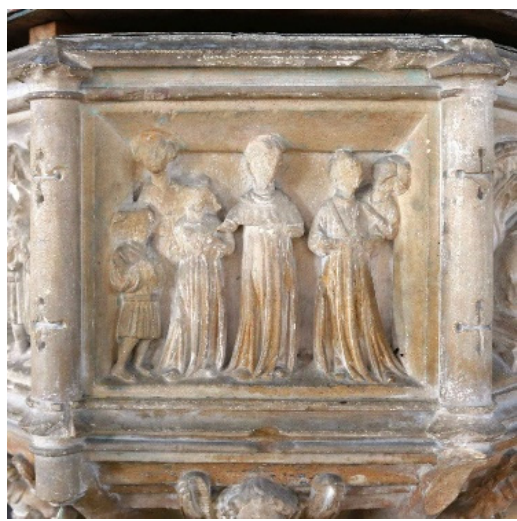
Figure 15. Eucharist. Source: Bob Mitchell.